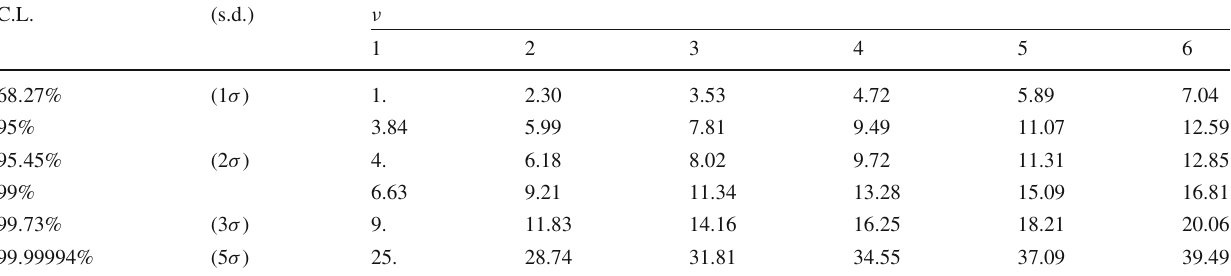
Table 4 (cid:9)χ 2 as function of confidence level (C.L.) and degree of freedom ( ν ). The values for ν > 2 are rarely used and only given for completeness